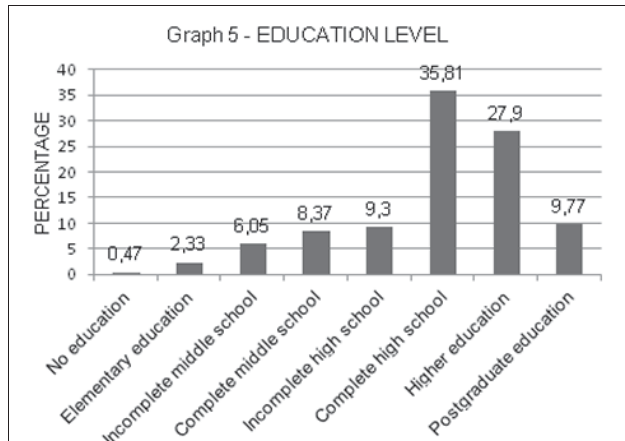
Fig. 1: gender evaluated